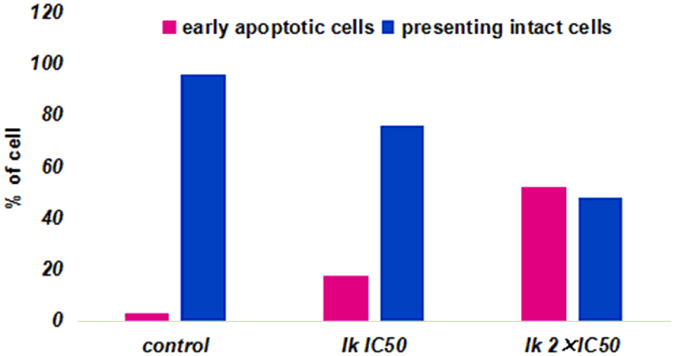
Apoptotic effect of compound.Ik was evaluated after 24 h treatment; bar graphs represent mean ± SD in at least three independent experiments.